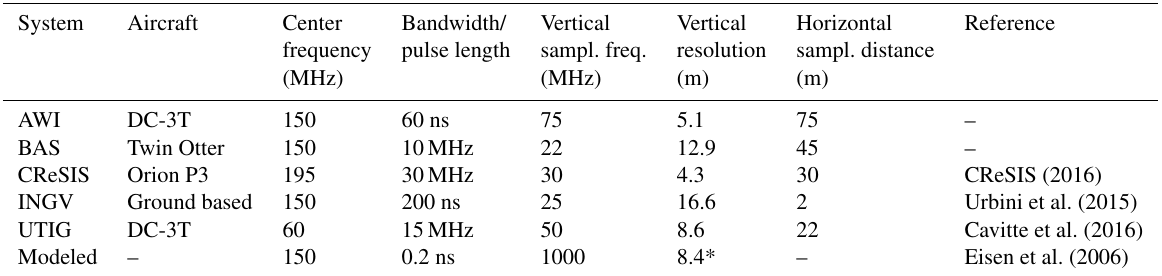
Table 1. Characteristics of the five RES systems. The fourth column gives either the bandwidth B in case of the chirp systems or the pulse length in case of the pulse and burst systems. The sixth column gives the vertical resolution due to bandwidth (for distinguishing two reflectors), determined